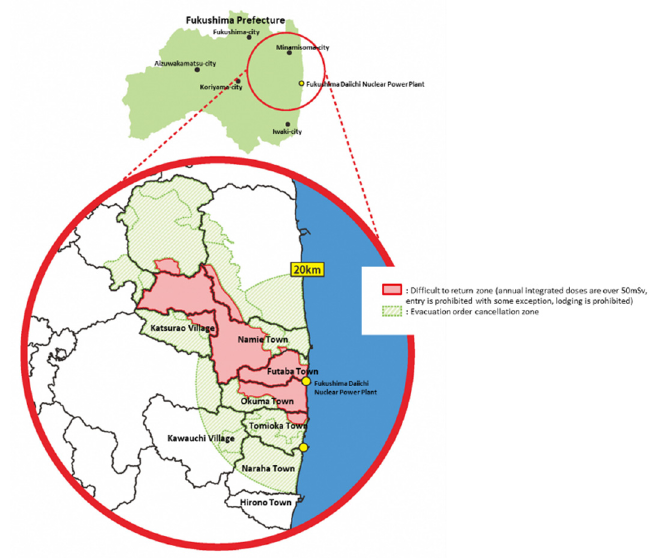
Figure 1. Evacuation order cancellation zone and difficult to return zone, as of April 2021. Red area: difficult to return zone (annual integrated doses are over 50 mSv, entry is prohibited with some exceptions, and lodging is prohibited); and green area: evacuation order cancellation zone.